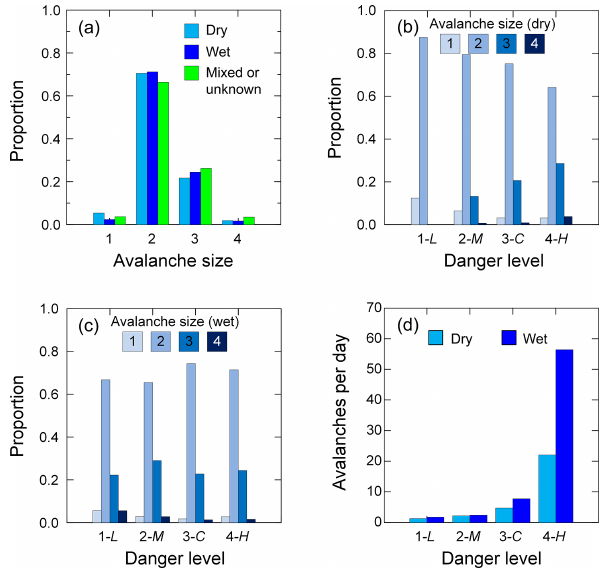
Figure 4. (a) Avalanche size distribution for dry-snow avalanches ( N = 7748), wet-snow avalanches ( N = 4056) and avalanches where the snow type was either recorded as mixed or it was not recorded at all ( N = 1941). Avalanche size distribution per danger level (1-Low to 4-High) for (b) natural dry-snow avalanches ( N = 3044) and (c) natural wet-snow avalanches ( N = 3955). (d) Num- ber of avalanches on a day with corresponding avalanche activity per danger level for dry-snow and wet-snow